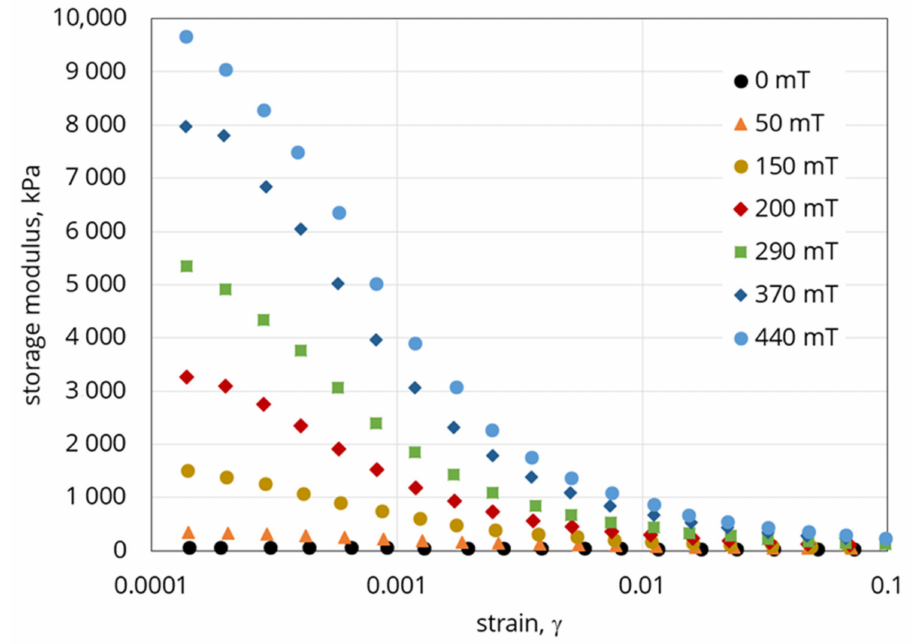
Figure 6. Shear modulus as a function of deformation in various magnetic fields.